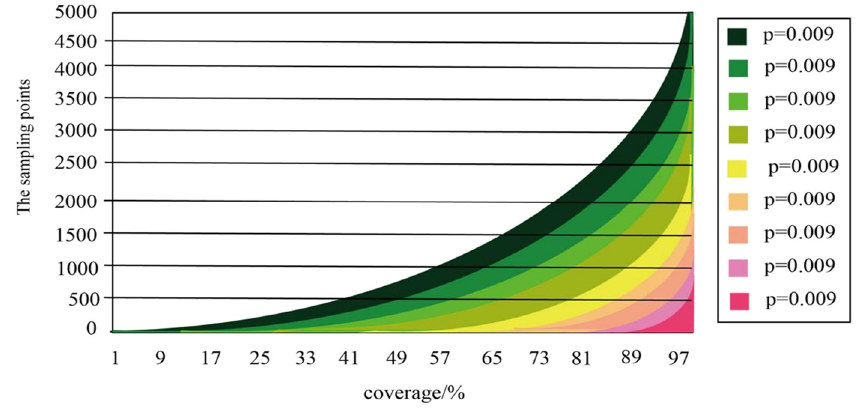
Figure 5: The q - curve cluster when p = 0.001 –